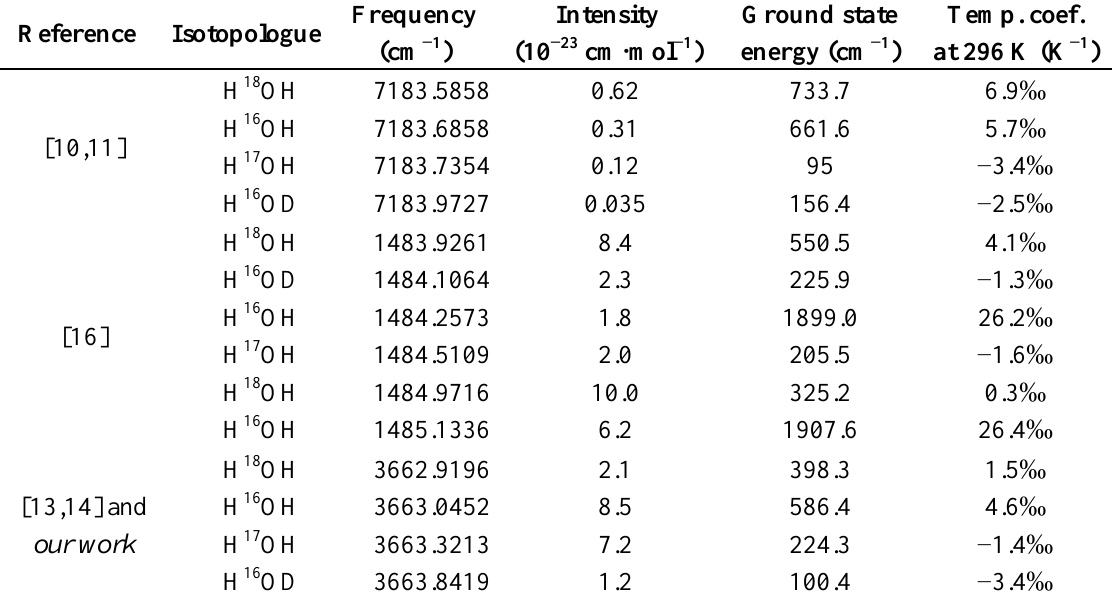
Table 1. Comparisons of line intensities, ground state energies and temperature coefficients between different IRLS operating at different wavelengths in the infrared spectral